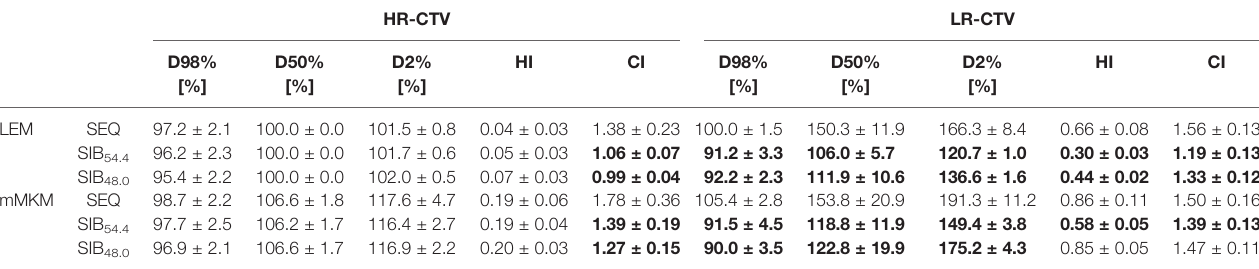
The values were normalized to the corresponding prescriptions. Statistically signi fi cant differences between the SEQ and SIB approaches are shown in bold (p-values are statistically signi fi cant after Bonferroni correction of fi ve tests, p < 0.01). CTV, clinical target volume; HR, high risk; LR, low risk; D%, dose to % of the CTV; HI, homogeneity index; CI, conformity index; LEM, local effect model; mMKM, modi fi ed microdosimetric kinetic model; SEQ, sequential boost; SIB, simultaneous integrated